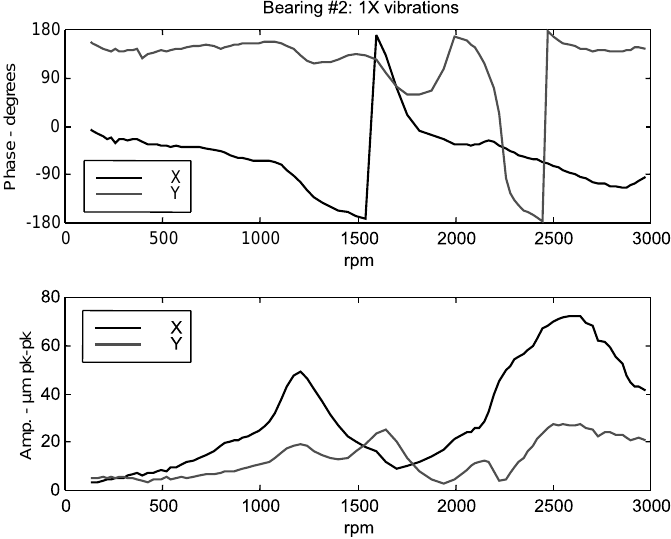
Fig. 10. Bode plot of the 1X experimental transient vibrations on bearing #2. These vibrations have been assumed as reference data X ref . Machine trip level is 180 µ m